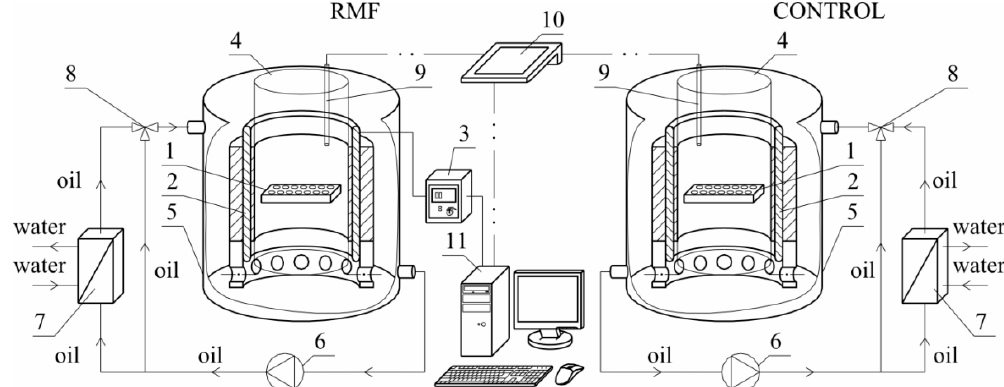
Figure 9. The sketch of experimental set-up: 1—cell culture microplate, 2—RMF generator, 3—AC transistorized inverter, 4—cylindrical glass vessel, 5—cooling jacket, 6—circulating pumps, 7—heat exchanger, 8—three-way valve, 9—microprocessor temperature sensor, 10—multifunctional meter, 11—personal computer.